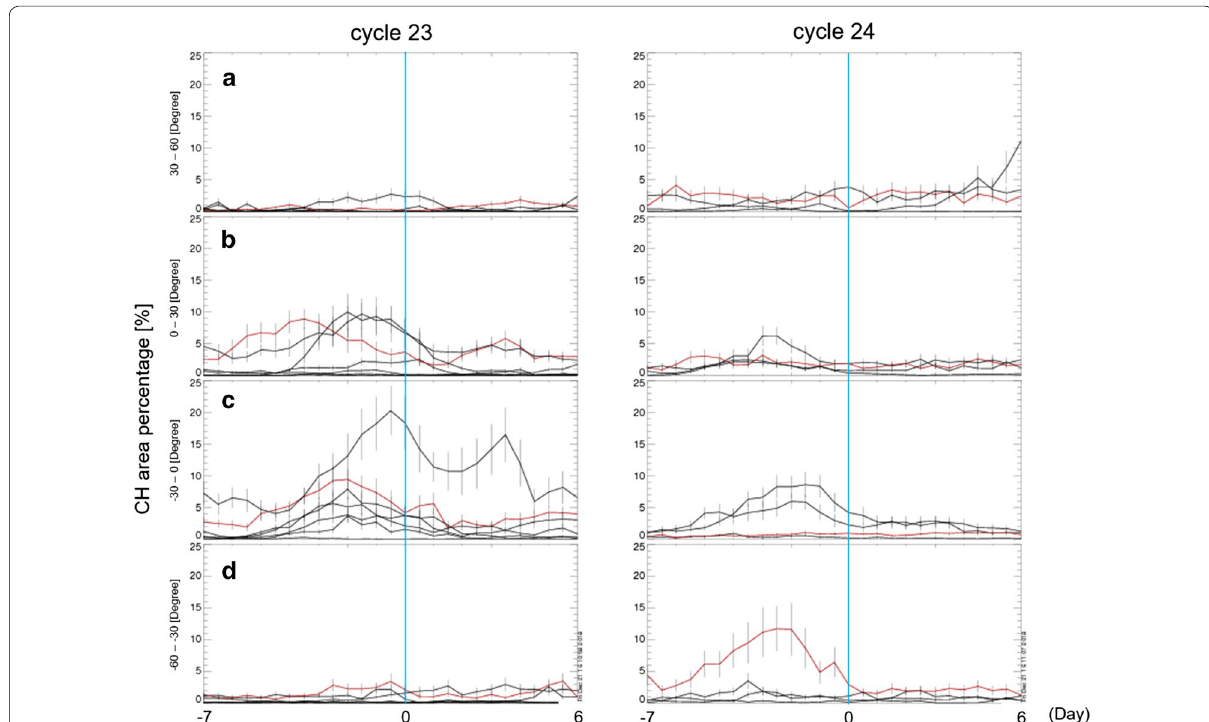
Fig. 7 Variation of the average CH area in the middle- to low-latitude regions with the data of every 2 years during solar cycle 23 (left panel) and 24 (right panel). The vertical light blue line represents the start time of an enhancement of solar wind velocity around the Earth’s orbit. Red lines in both panels indicate the variation of the period of the solar maximum, from 2000 to 2001 (the left panel) and from 2013 to 2014 (the right panel)